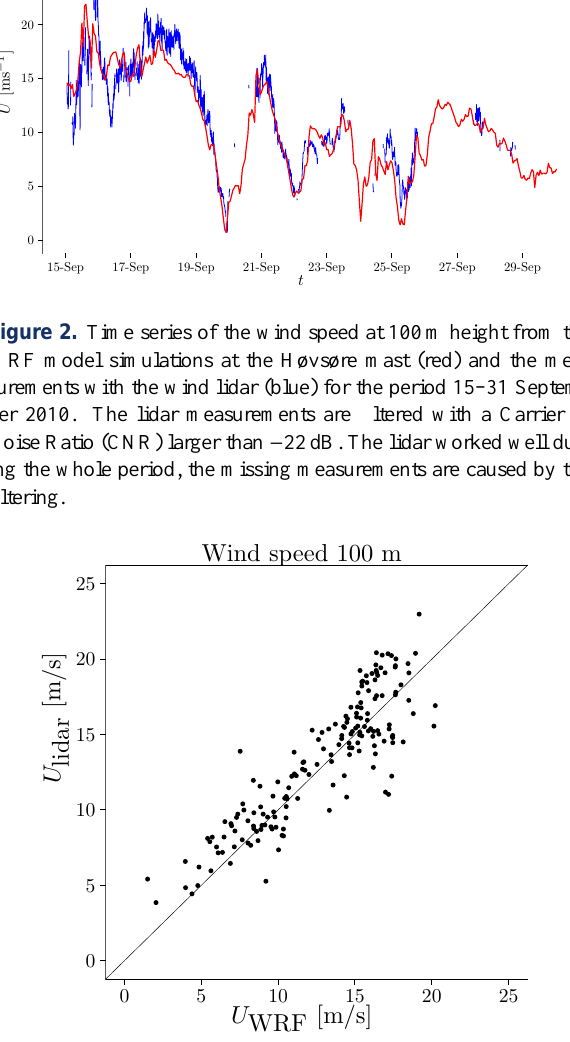
Figure 5. Normalized mean wind speed profile for the entire pe- riod, the full line shows the WRF simulations normalized with the observed u ∗ 0 and the dashed dotted line with the modelled u ∗ 0 , the triangles are cup anemometer measurements at the mast and the dots are wind lidar